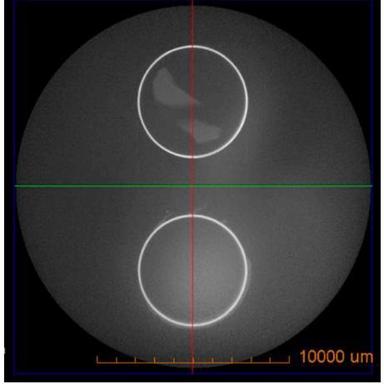
Micro-CT images showing contact area (light-grey area) between material sample and bottom of aluminum pan: (left) TPU sample only and (right) TPU sample mounted on HTA, with light areas indicating HTA.